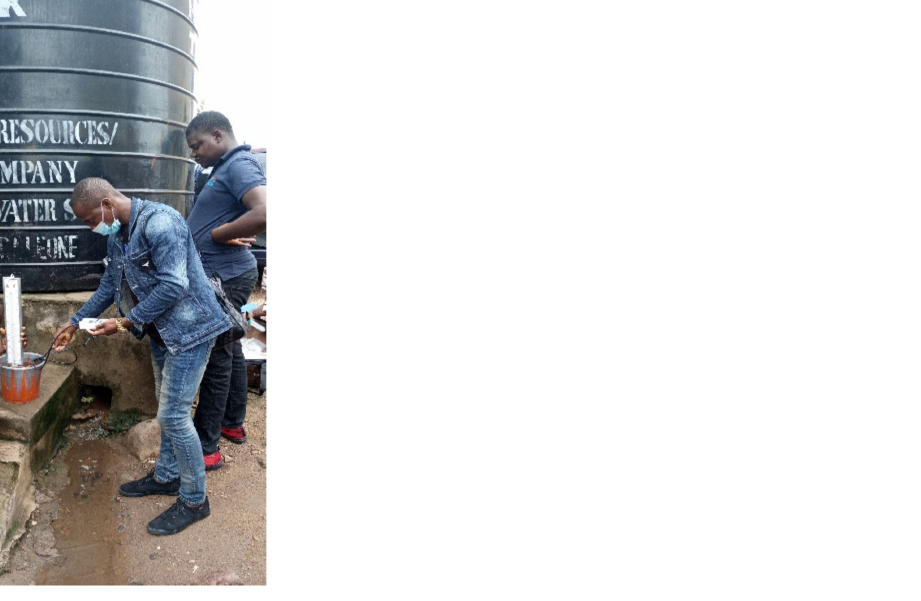
Figure 5. Physical testing of a standpipe connected to a storage tank. A standpipe connected to a storage tank (10,000 L capacity) depicts physical testing of the pH of the water and total dissolved solids using pH meter and